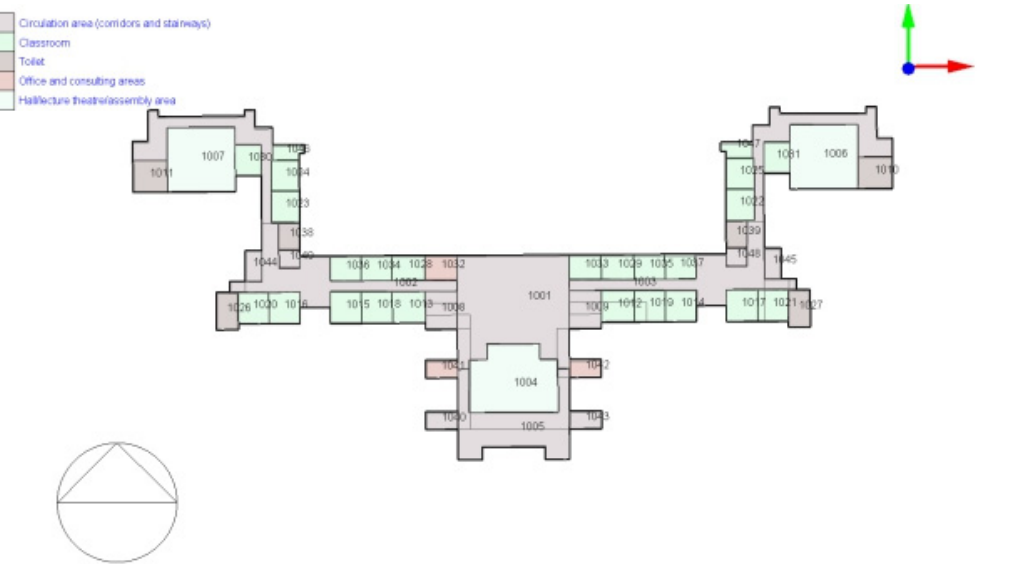
Figure 3. Sample building first-floor layout in DesignBuilder.